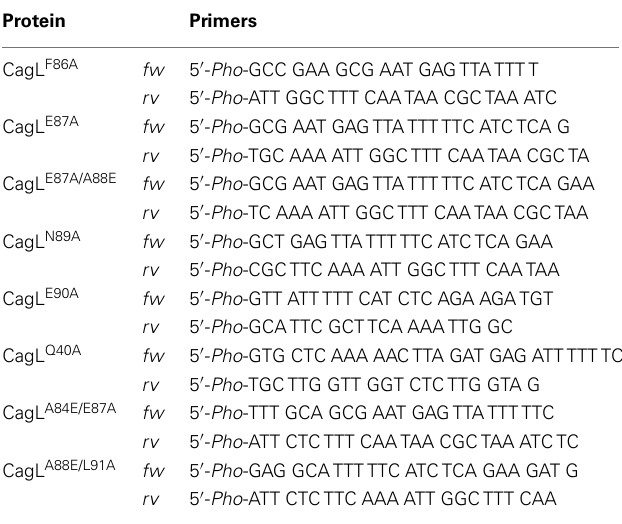
Table 1 | Primers used for generating the different CagL